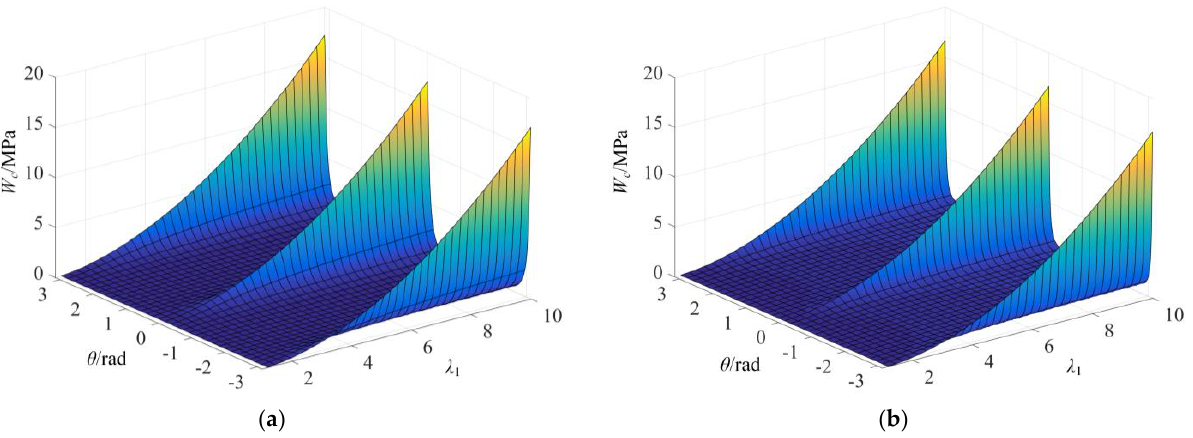
Figure 5. Distribution of CED under typical strain state: ( a ) Uniaxial tension ( b = λ 1 −3/2 ); ( b ) simple shear ( b = λ 1 −2 ).